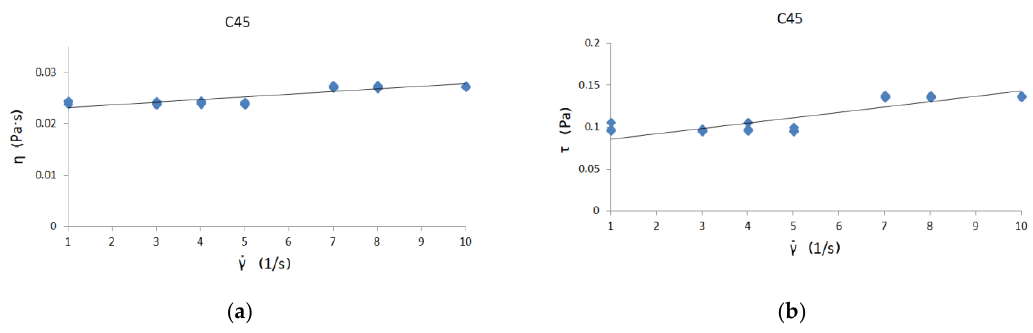
Figure 8. ( a ) Viscosity curve for C45 steel at 1530 °C; ( b ) flow curve for C45 steel at 1530 °C.